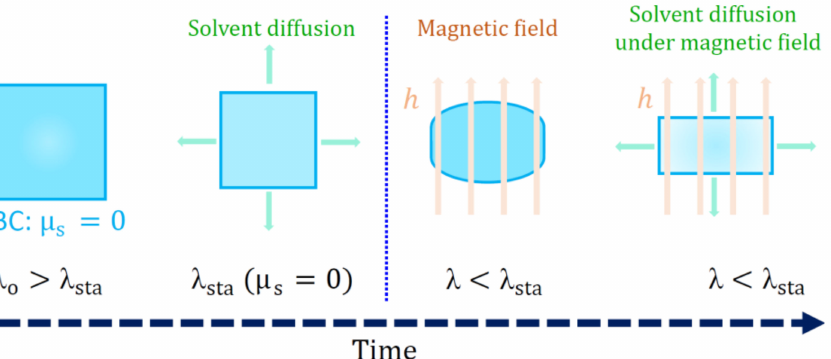
Figure 4. Stages of the deformation process of an MAH surrounded by a solvent with null chemical potential ( µ s = 0) and exposed to an external magnetic field. The MAH experiences, in a timeline: (i) initial swelling ratio λ o ; (ii) solvent diffusion until reaching a stable swelling ratio λ sta ; (iii) application of an external magnetic field h ; solvent diffusion until reaching a new stable state. Figure adapted from Garcia-Gonzalez and Landis